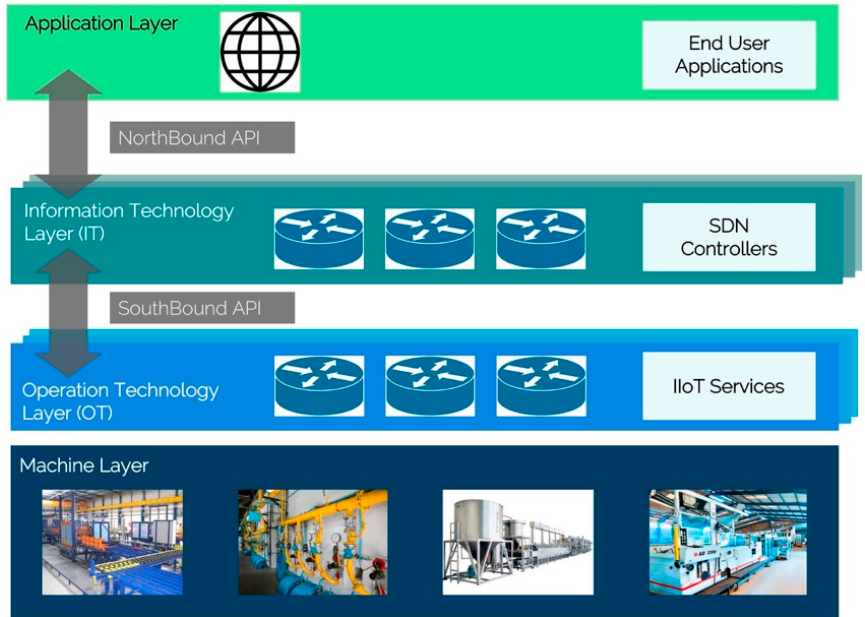
Figure 1. SDN-enabled architecture for the Industrial Internet of Things.